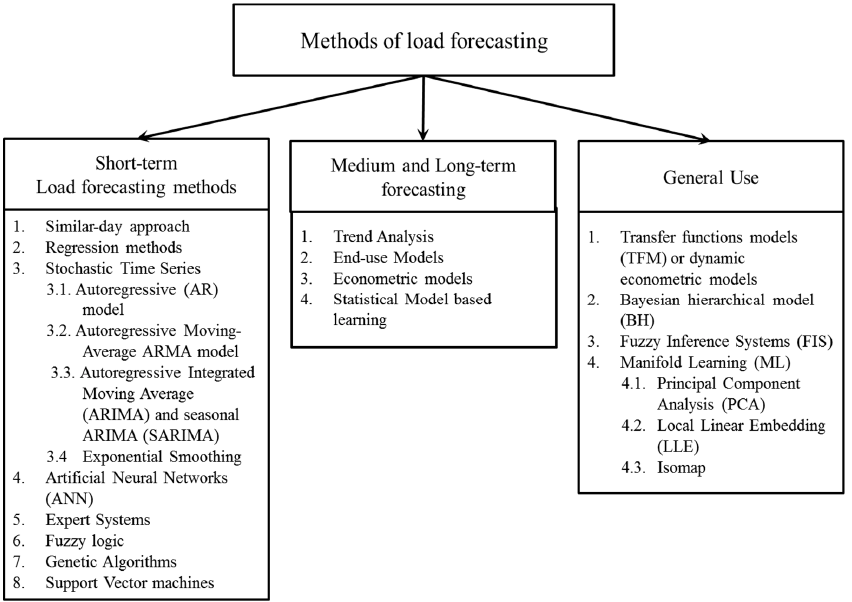
Figure 1. Available methods applied in each case of load forecasting, based on forecasting horizon (short ‐ term, medium ‐ term, or long ‐ term).